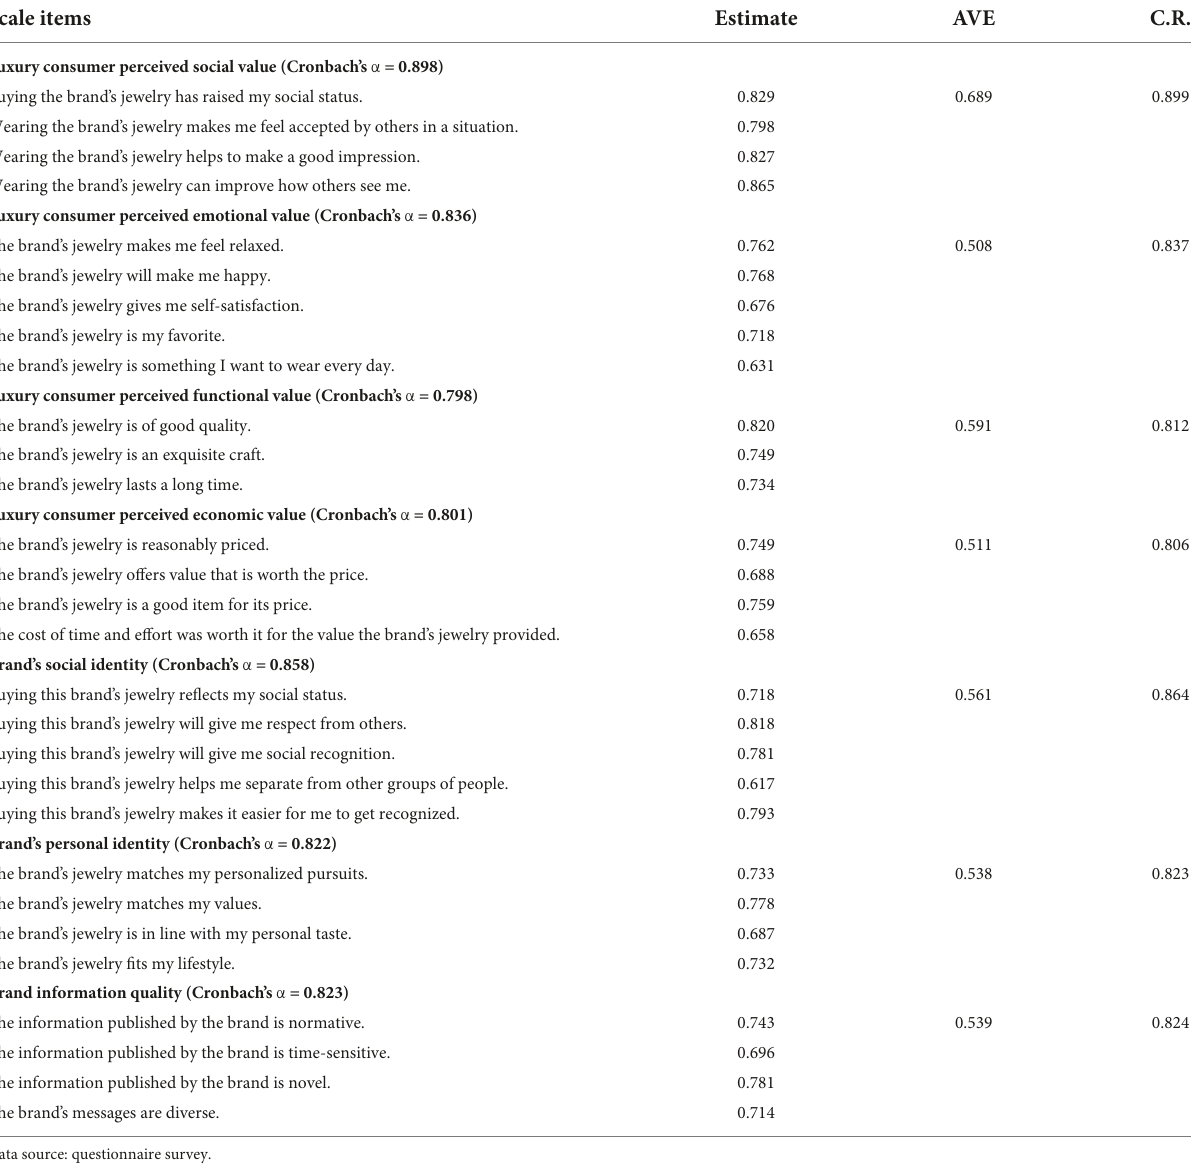
TABLE 3 Assessment of reliability and convergent validity.